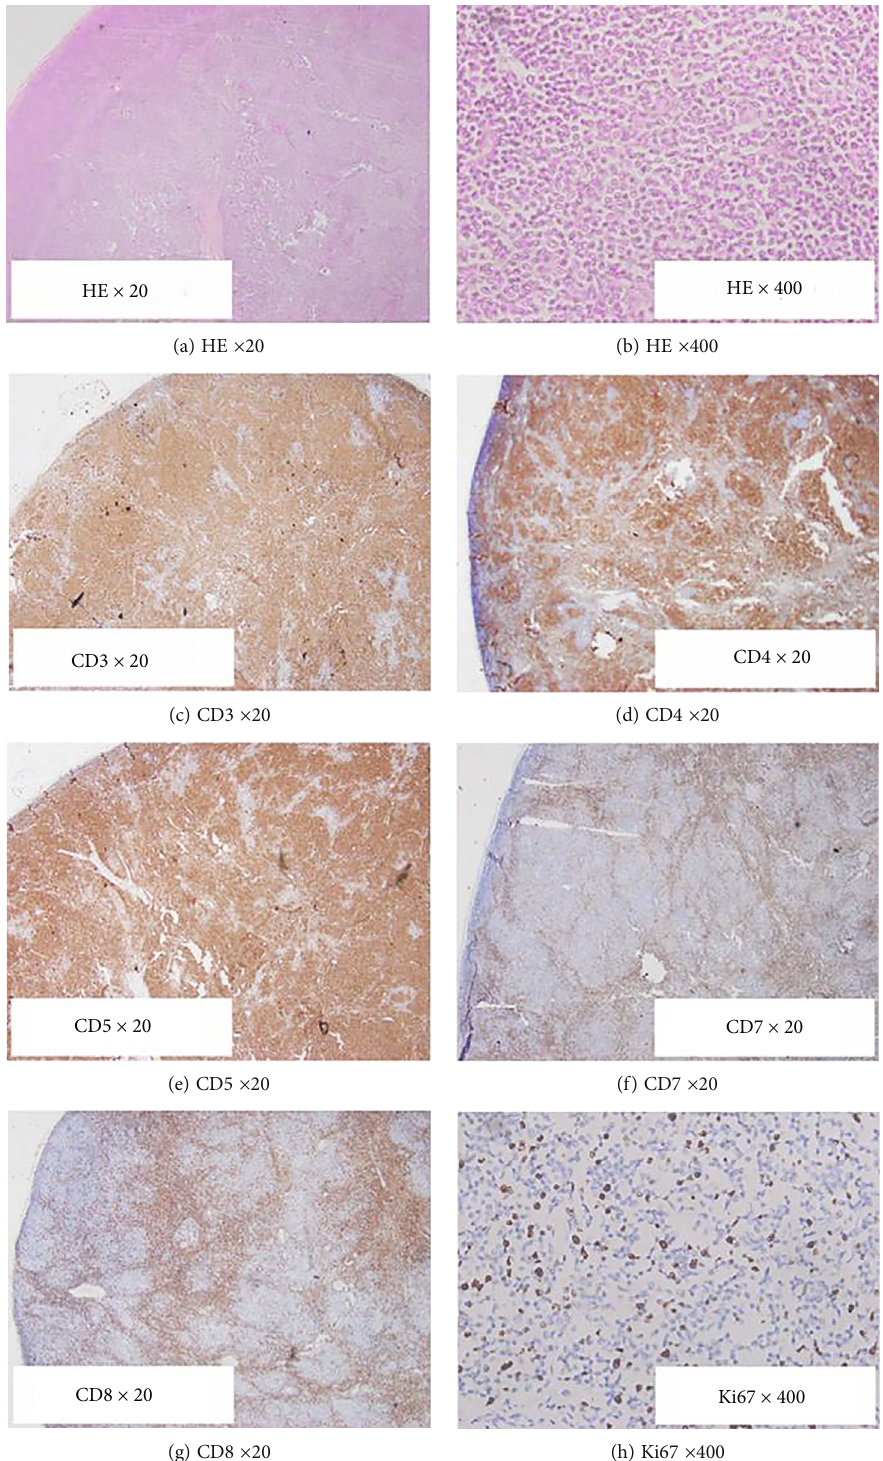
Figure 6: Photomicrographs of histopathology (a, b) and immunohistochemistry (c – h) of the excised cervical lymph node. CD2 staining and B cell markers are not shown. The legends are expressed as ½ stain (cid:2) × ½ total magnification (cid:2)